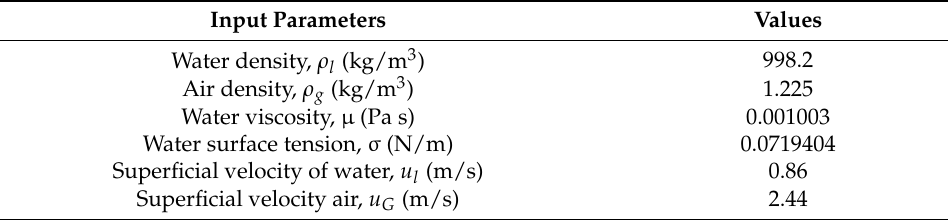
Table 3. Fluid and gas properties employed in the simulation work.